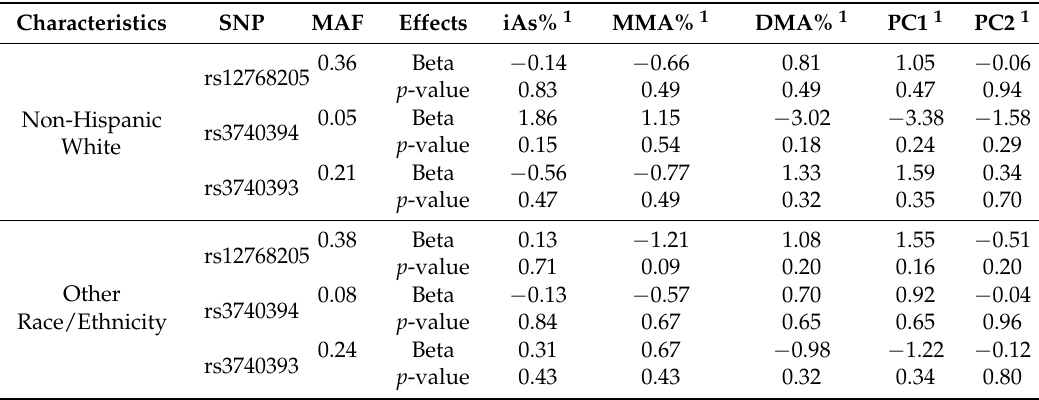
Table 4. Allele effects of AS3MT variants by